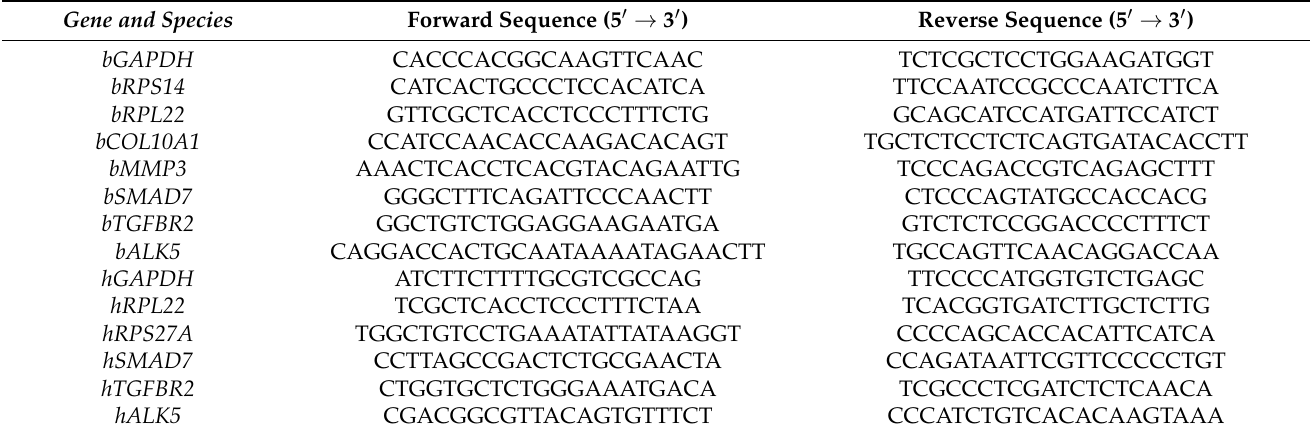
Table 1. Primer sequences as used in this